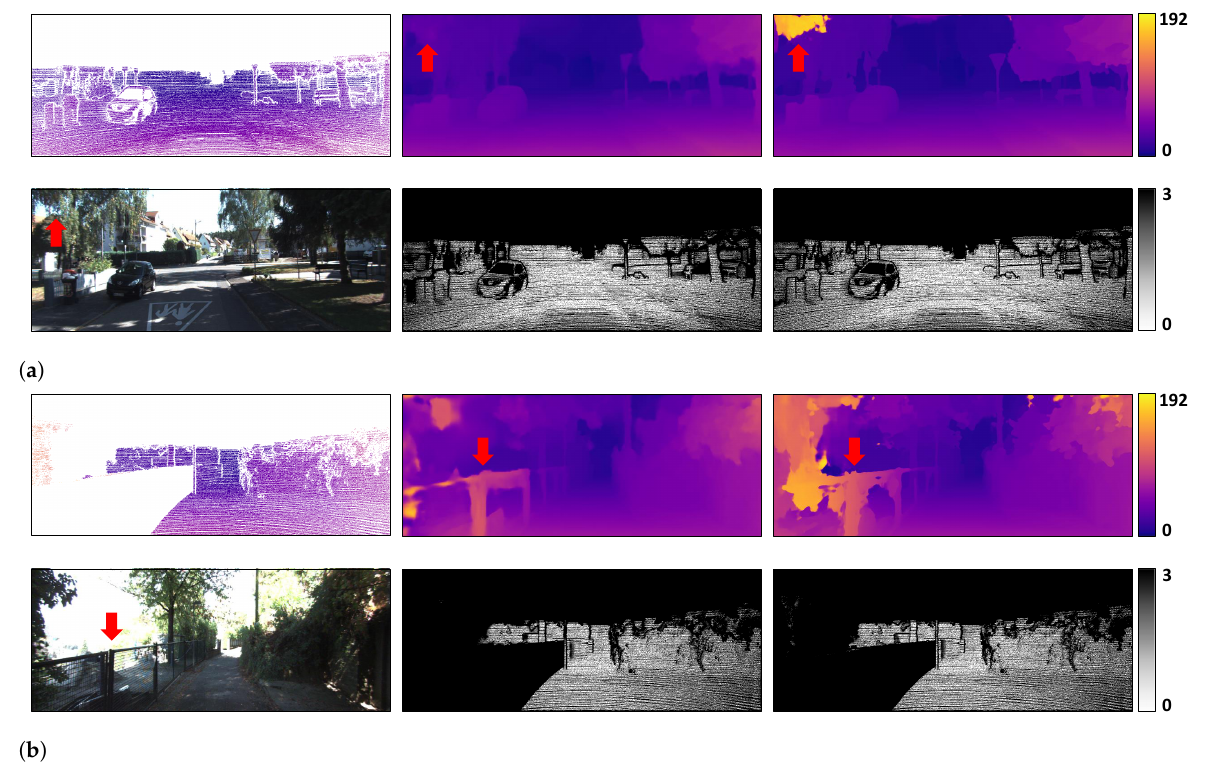
Figure 4. Visual comparison on KITTI-2012 data. Two test cases are displayed in subfigure ( a , b ). In each subfigure, the disparity maps from the ground truth, GA-Net-PyramidID+SPN and GA-Net are displayed from left to right in the first row. The second row provides the master epipolar image and the corresponding error map of each model. Regions where the proposed algorithm outperforms GA-Net are marked with red